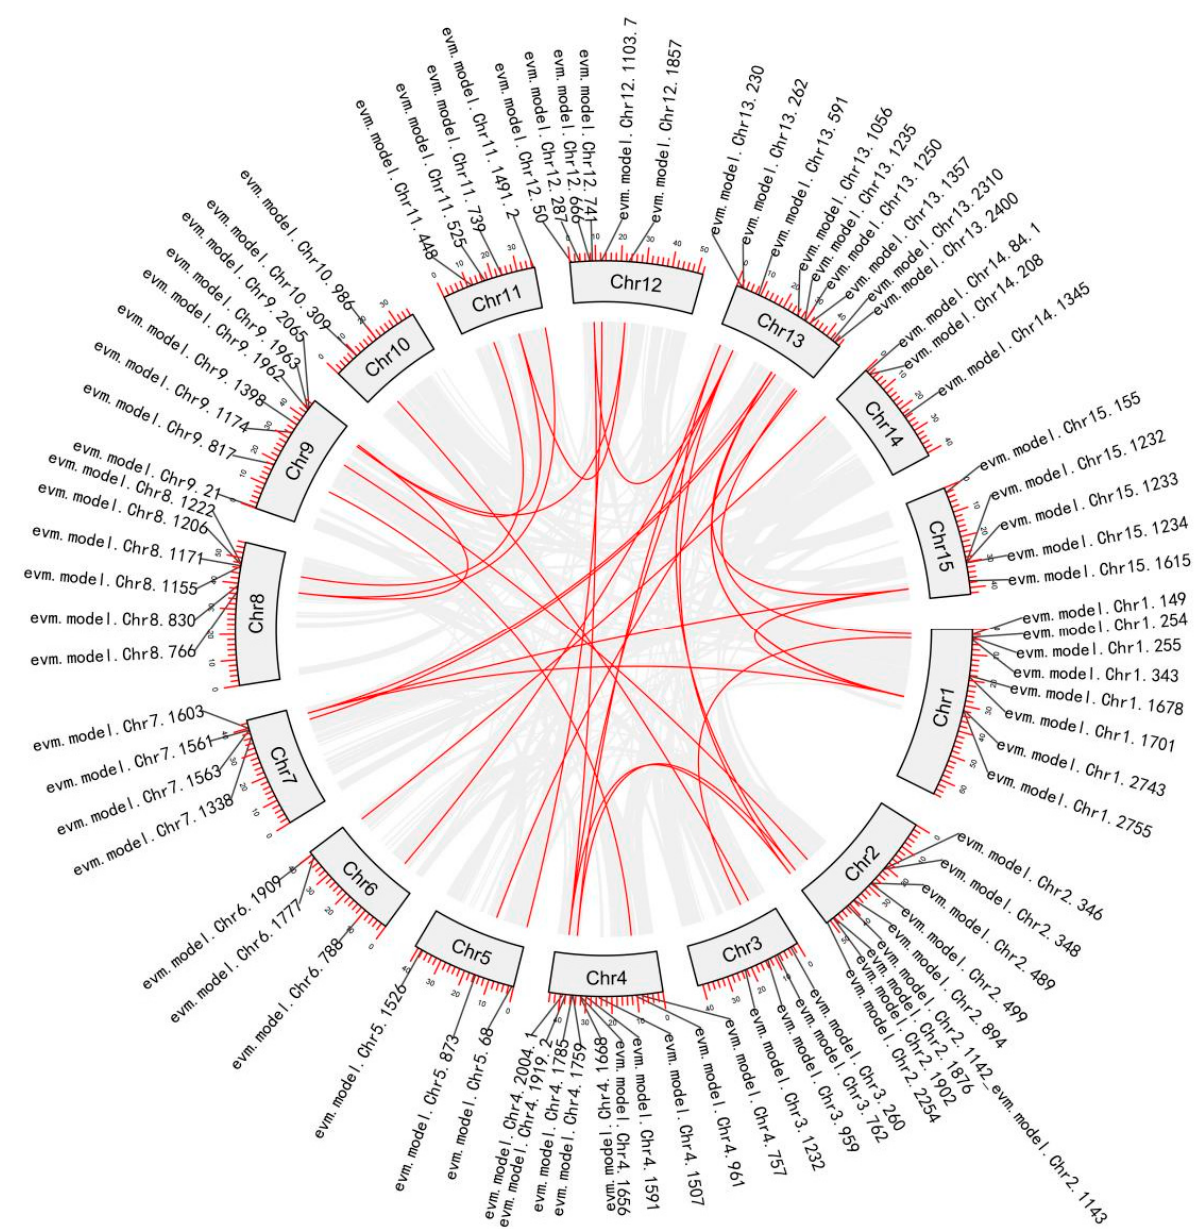
Figure 8. Distribution and duplication of DolNAC s. Gray lines represent the chromosomes of D. oleifera . The scales on the chromosomes represent the chromosome length. The red lines indicate duplicated DolNAC gene pairs.